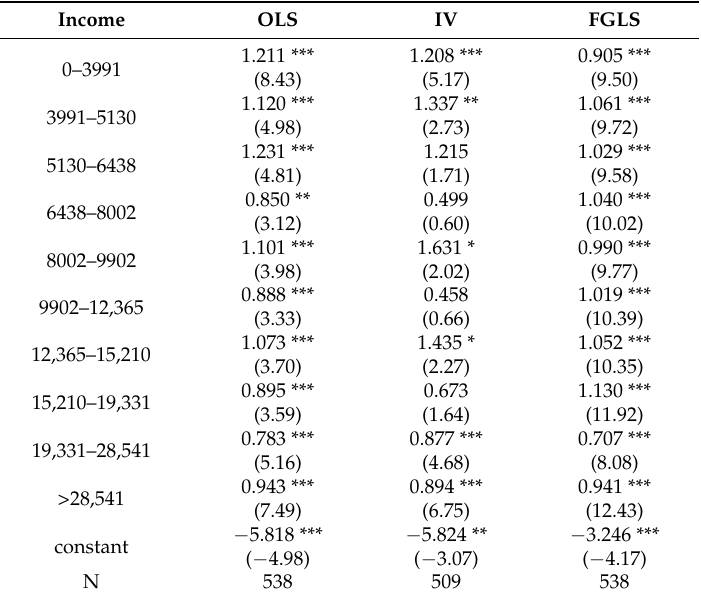
Table 4. Estimate results of different estimate